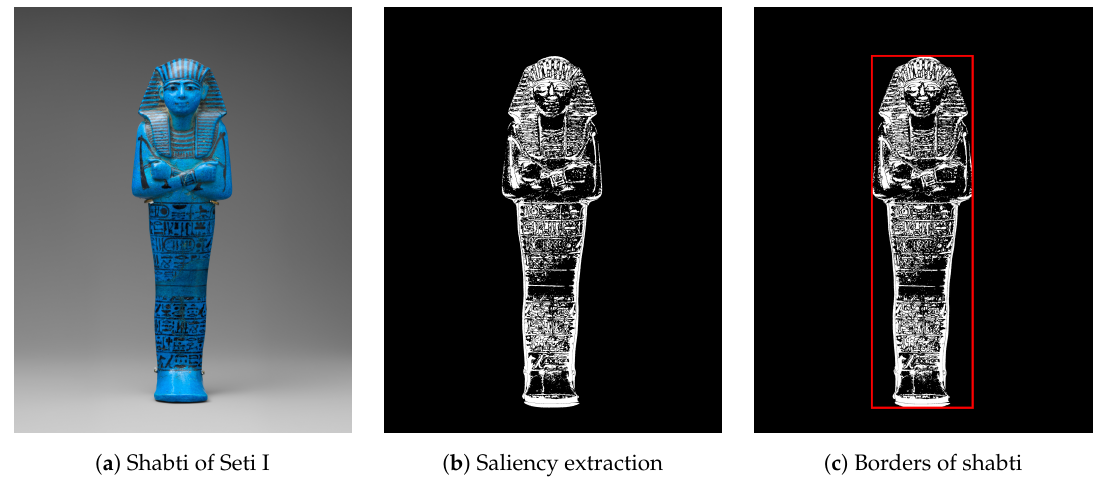
Figure 6. Shabti of Seti I (1294–1279 BC) at MET (Metropolitan Museum of Art), New York.